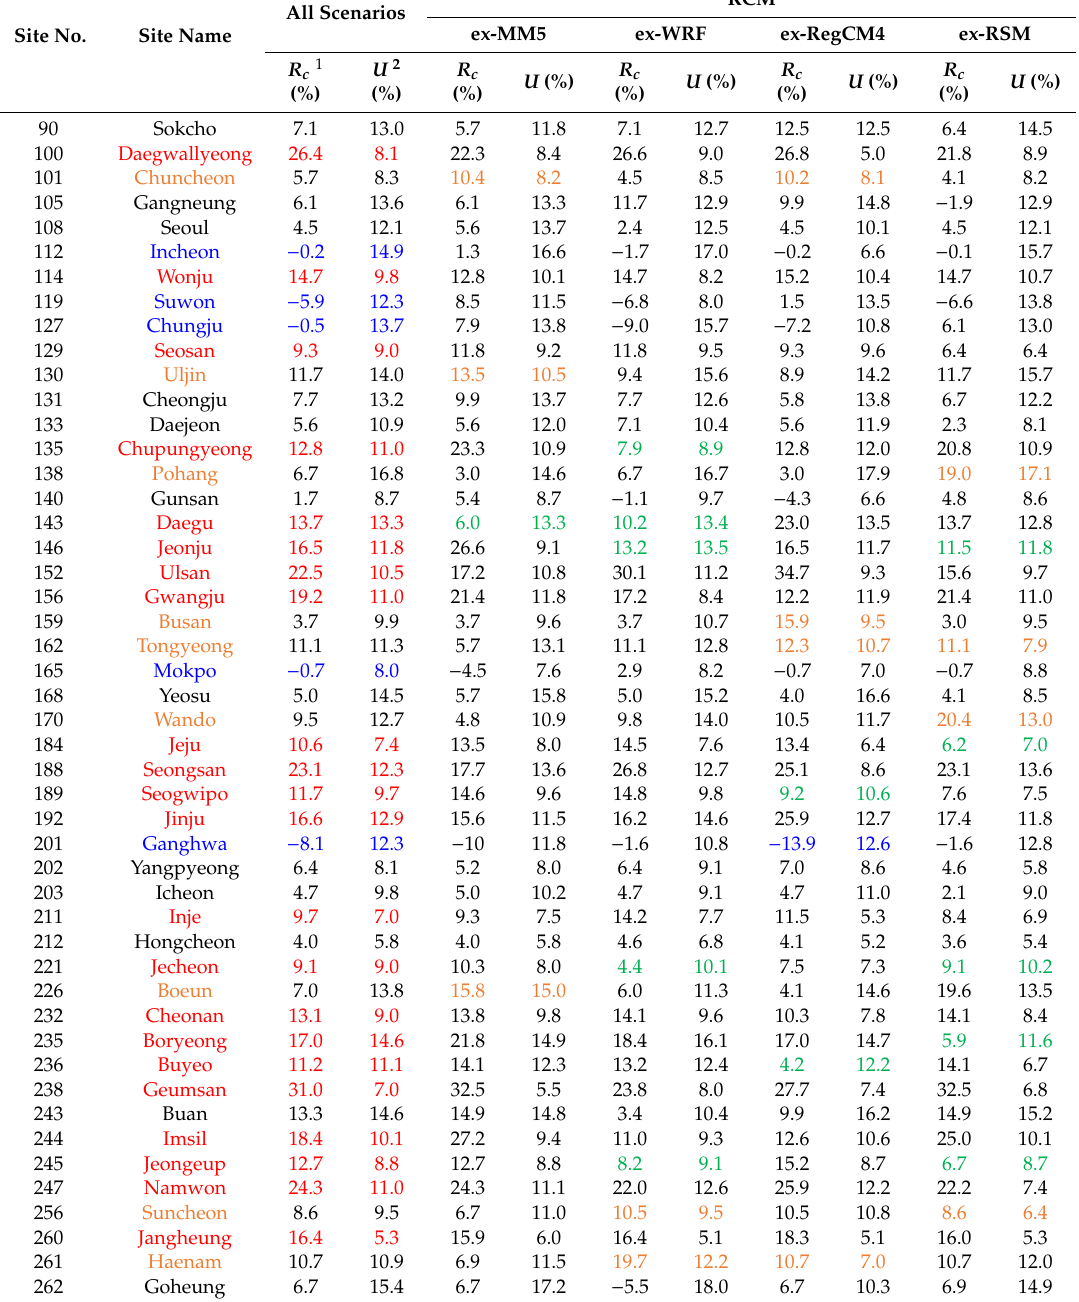
Table 3. Rate of change and its uncertainty for RCM